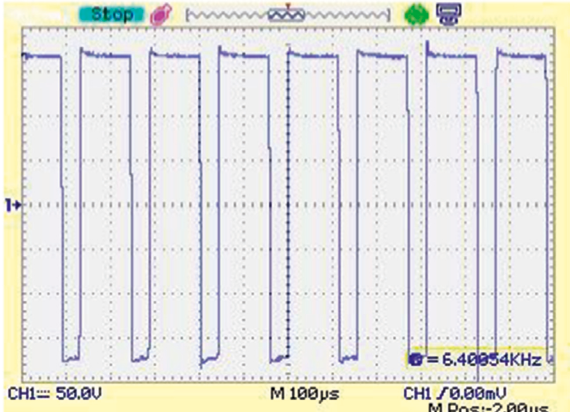
Figure 25: Experimental results of inverter